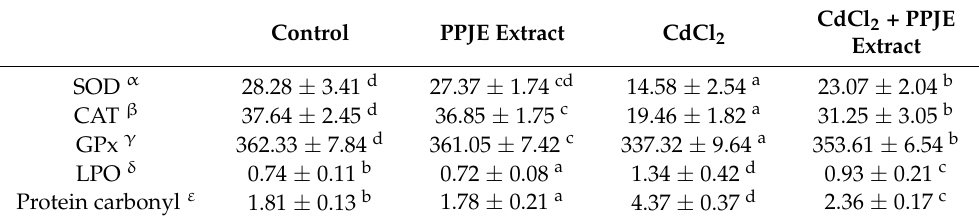
Table 4. Antioxidant enzyme activities and stress biomarkers levels in liver tissue of the studied groups. Control rats. PPJE extract (250 mg/kg)-treated rats. CdCl 2 (1 mg/kg)-treated rats. CdCl 2 + PPJE extract (250 mg/kg)-treated rats. α : U mg − 1 protein; β : µ moles/H 2 O 2 consumed min − 1 mg − 1 of protein; γ : nmoles GSH min − 1 mg − 1 of protein; δ : nmoles of MDA g − 1 of tissue; ε : nmoles mg − 1 of protein.